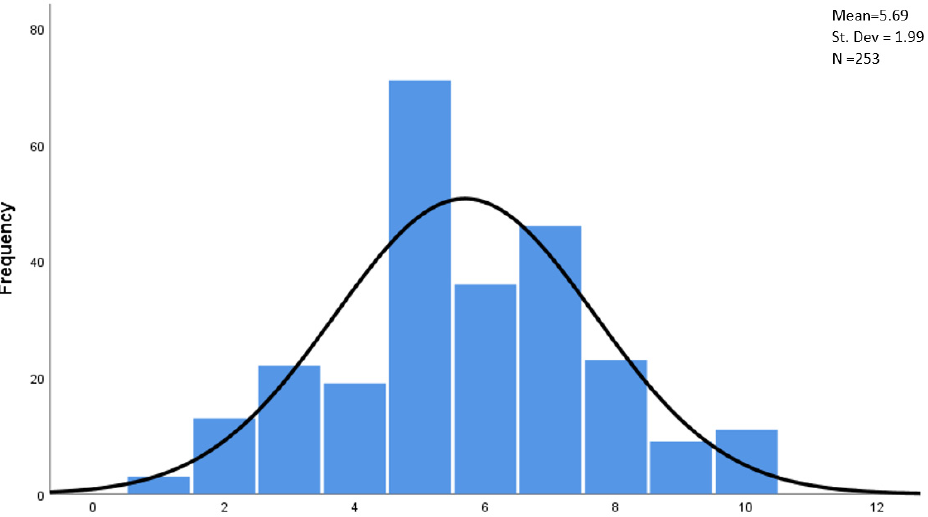
Figure 1. Scale of the level of satisfaction with the current way of practicing the profession of pharmacist.